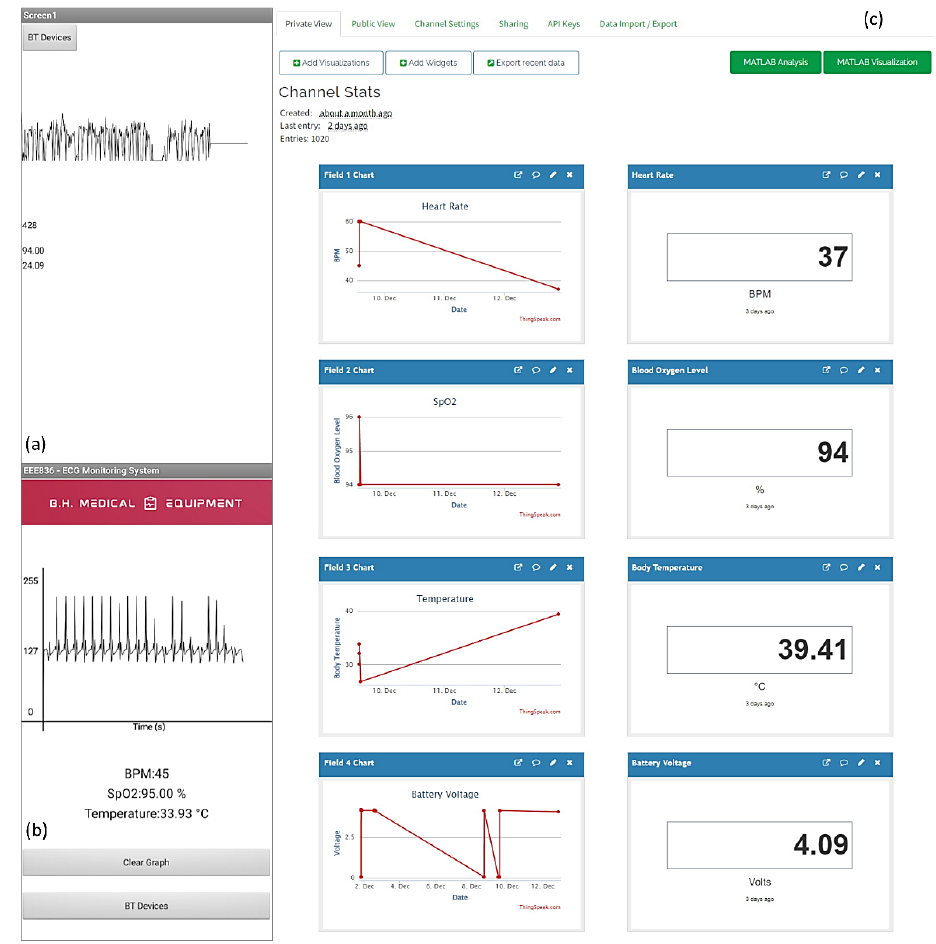
Figure 7. ( a ) Android App V1.0, ( b ) Android App V2.4, and ( c ) the ThingSpeak